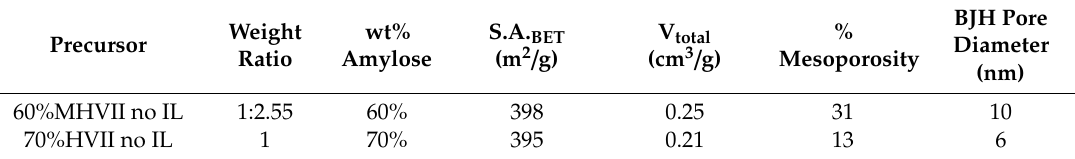
Table 4. Nanoporosity data of mesoporous carbons obtained from the modified Starbon ® process.